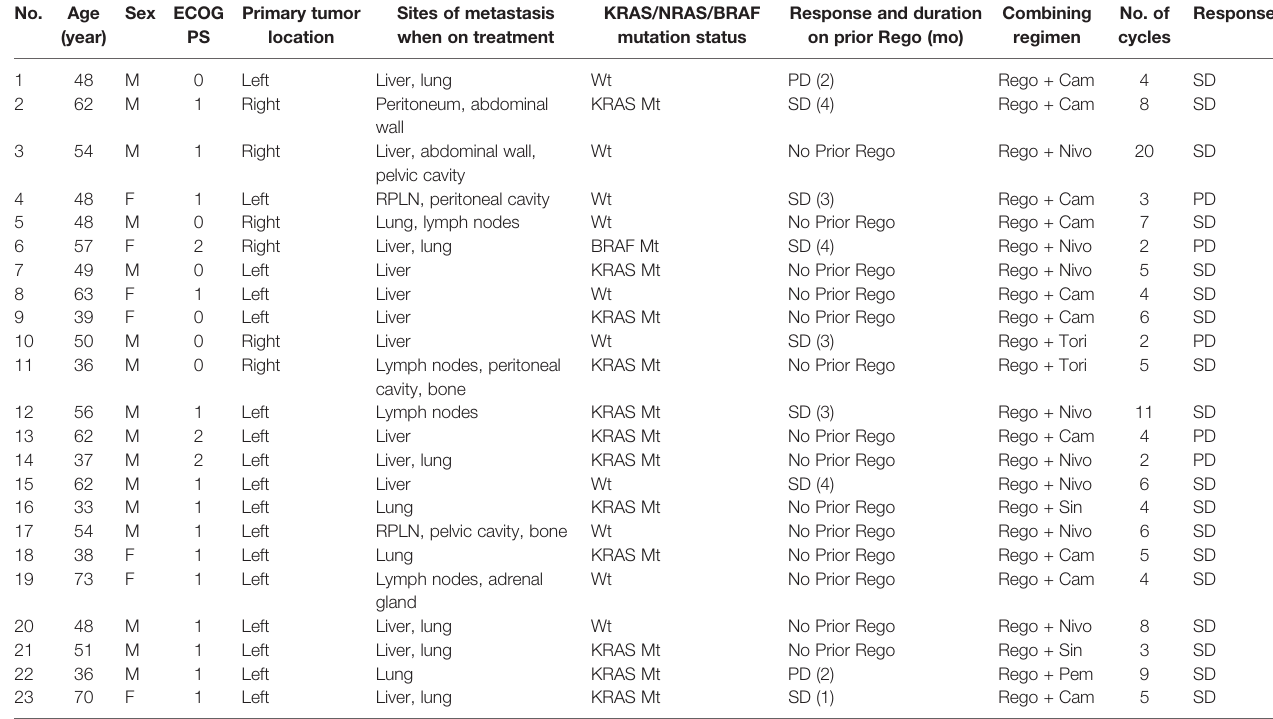
TABLE 2 | Characteristics of individual patients with pMMR/MSS mCRC retrospectively analyzed in this study. No. Age Sex ECOG (year)